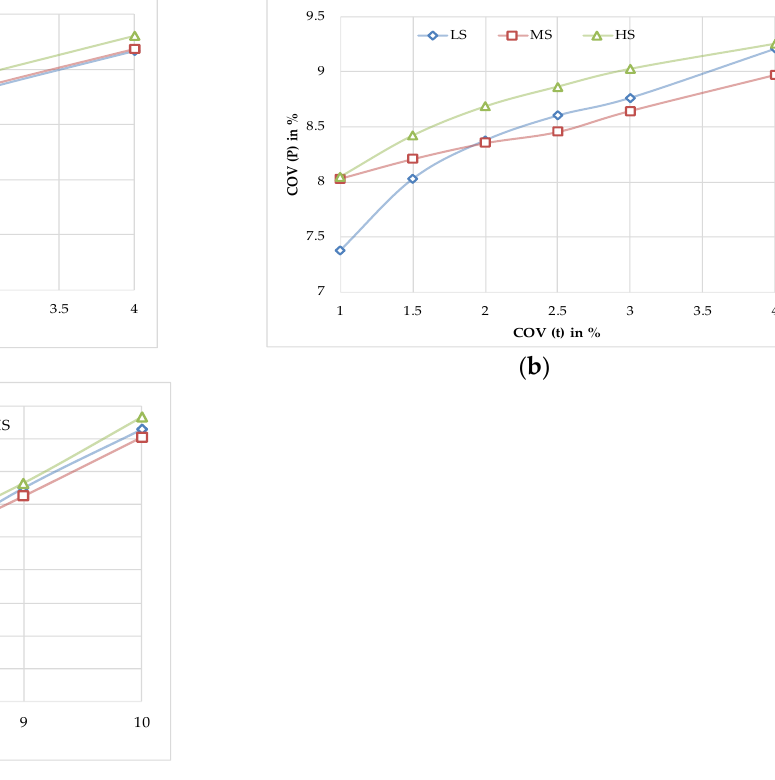
Figure 2. Effect of COV of ( a )diameter, ( b ) thickness and ( c ) strength variables on the model burst strength ( P ) for the top model in each category.